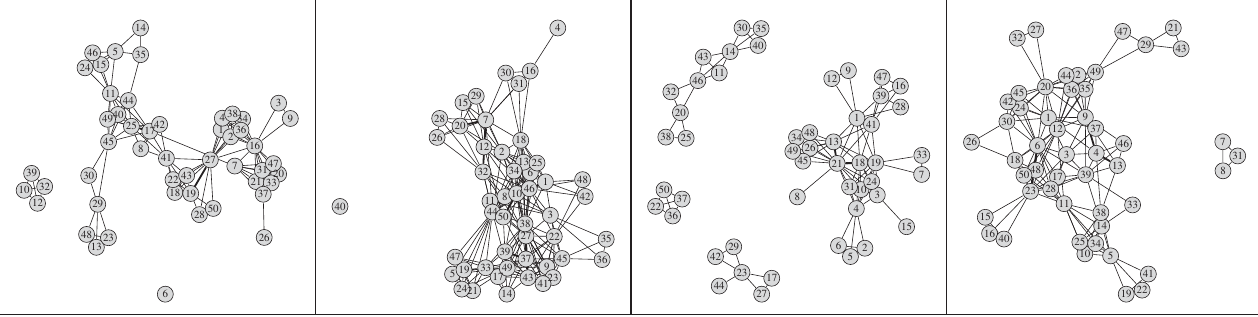
FIG. 11. Representative CCM graphs. These are some representative graphs for the CCM using optimized input parameters. Qualitatively they match up much better to the sorter graphs seen in Fig.